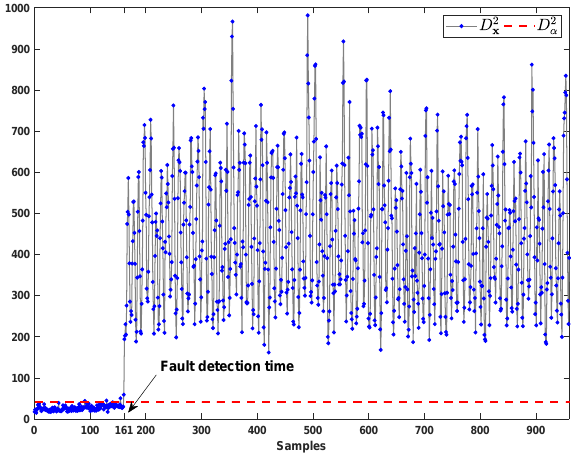
Figure 20. The fault detection results by kNN for fault 14 of